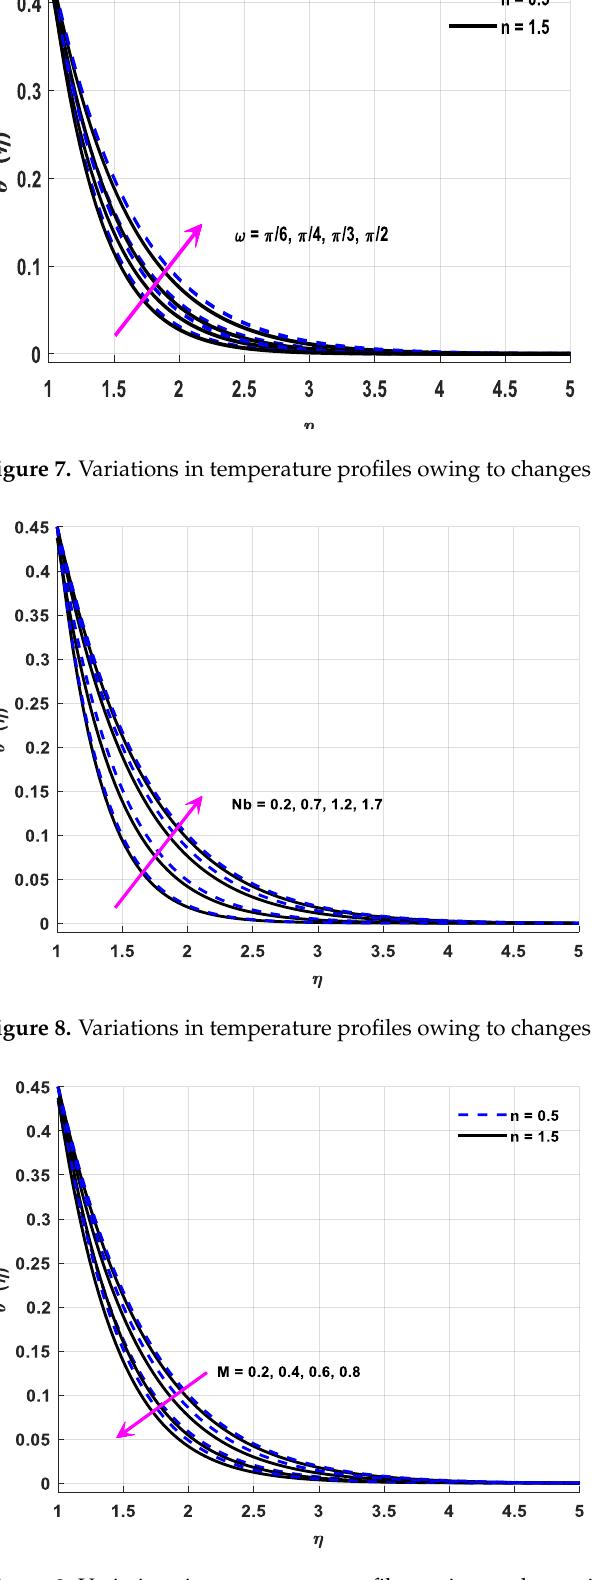
Figure 9. Variations in temperature profiles owing to change in M .